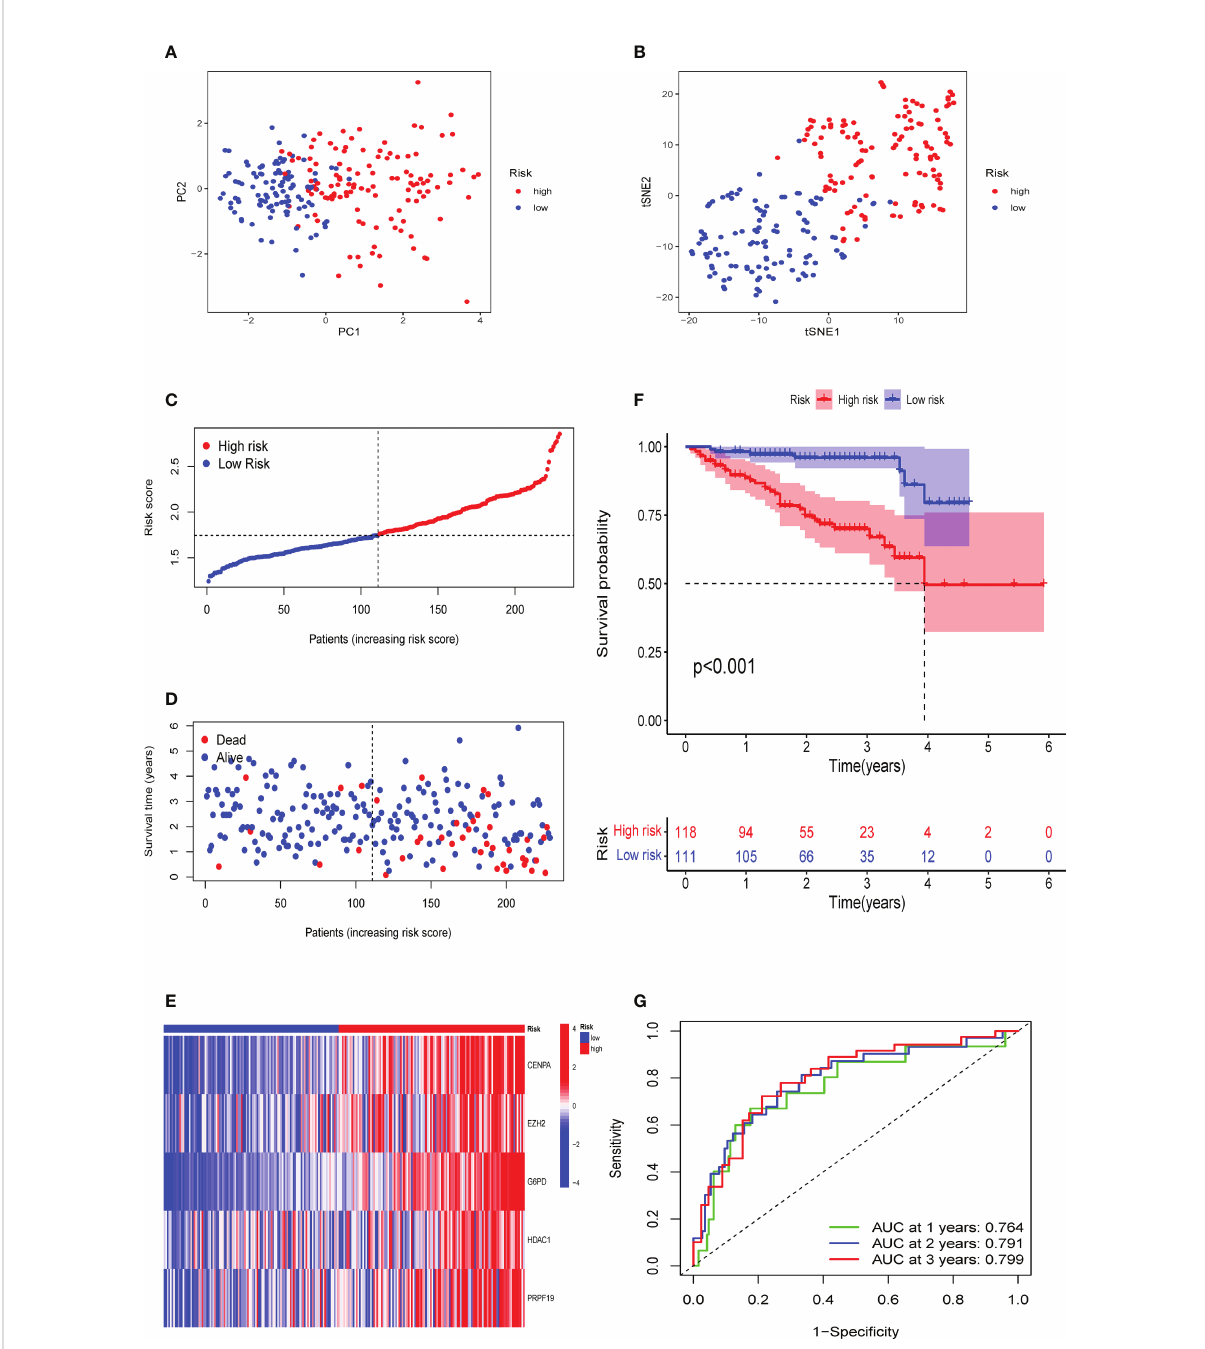
FIGURE 5 Veri fi cation of the CS signature in the testing cohort GSE14520. (A) PCA and (B) t-SNE analysis of the testing cohort GSE14520. (C, D) Patterns of alteration in patient survival status and survival time between the high- and low-risk groups based on the accumulation in CS scores. (E) Heat map visualization of the expression trend of 5 CS genes with increasing CS score in the GSE14520 cohort. (F) Survival analysis of patients in the high-risk and low-risk groups in the validation cohort testing cohort GSE14520. (G) Validation of time-dependent ROC curve results for the risk model in the